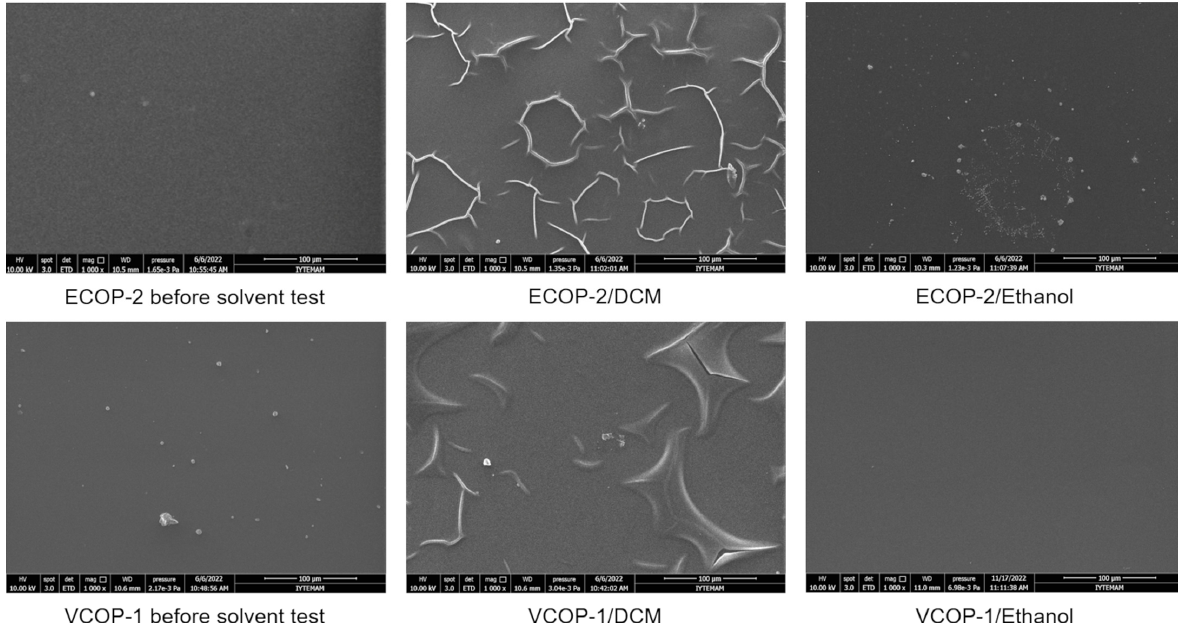
Figure 8. SEM images of ECOP-2 and VCOP-1 copolymers before and after immersion in DCM and ethanol for 30 min.